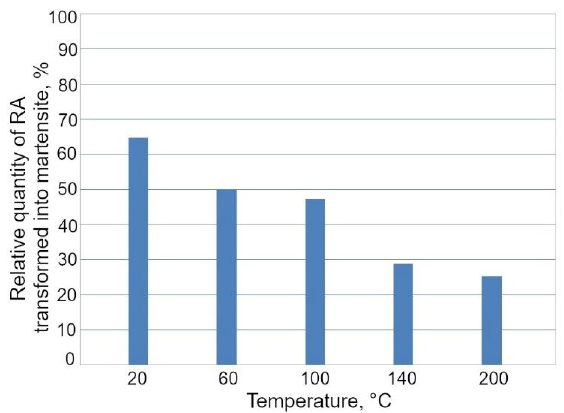
Figure 10. Relative quantity of retained austenite (RA) transformed into martensite at different temperatures. Table 2. Tensile test results of the investigated alloy at different deformation temperatures.